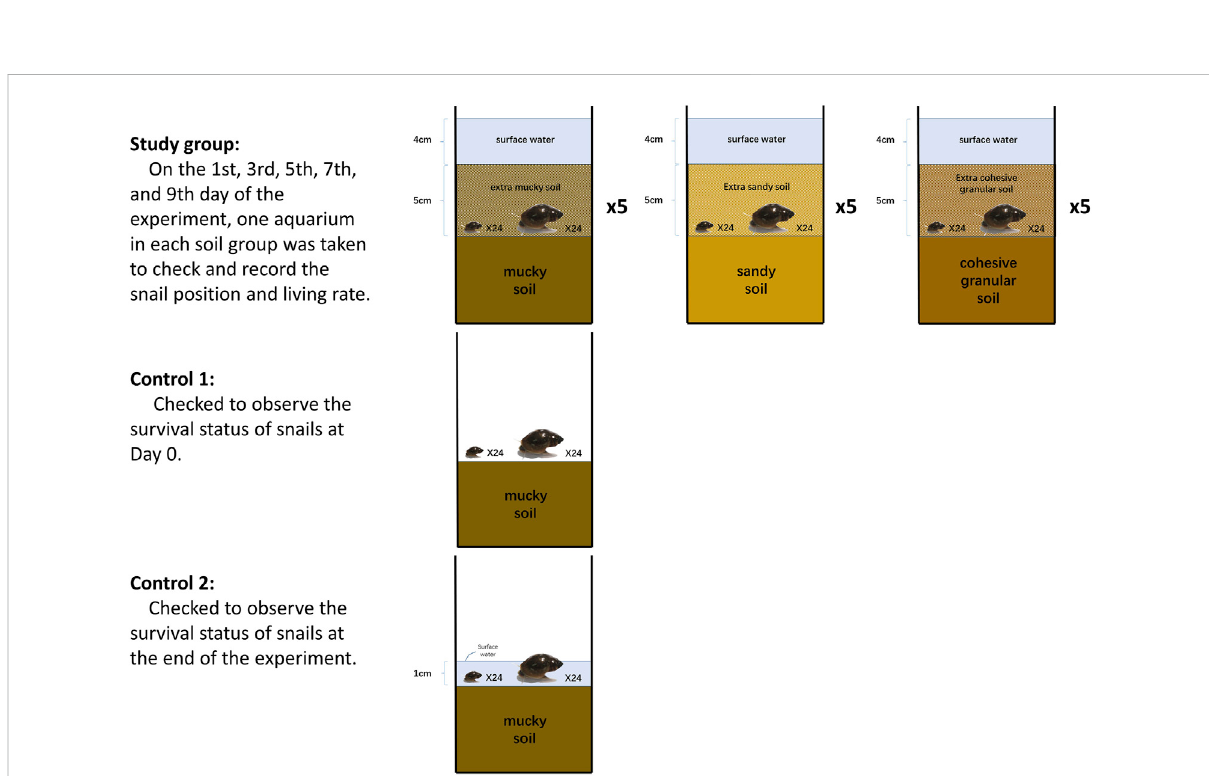
FIGURE 3 Experimental design for the upward movement of B. globosus snails in re-watered